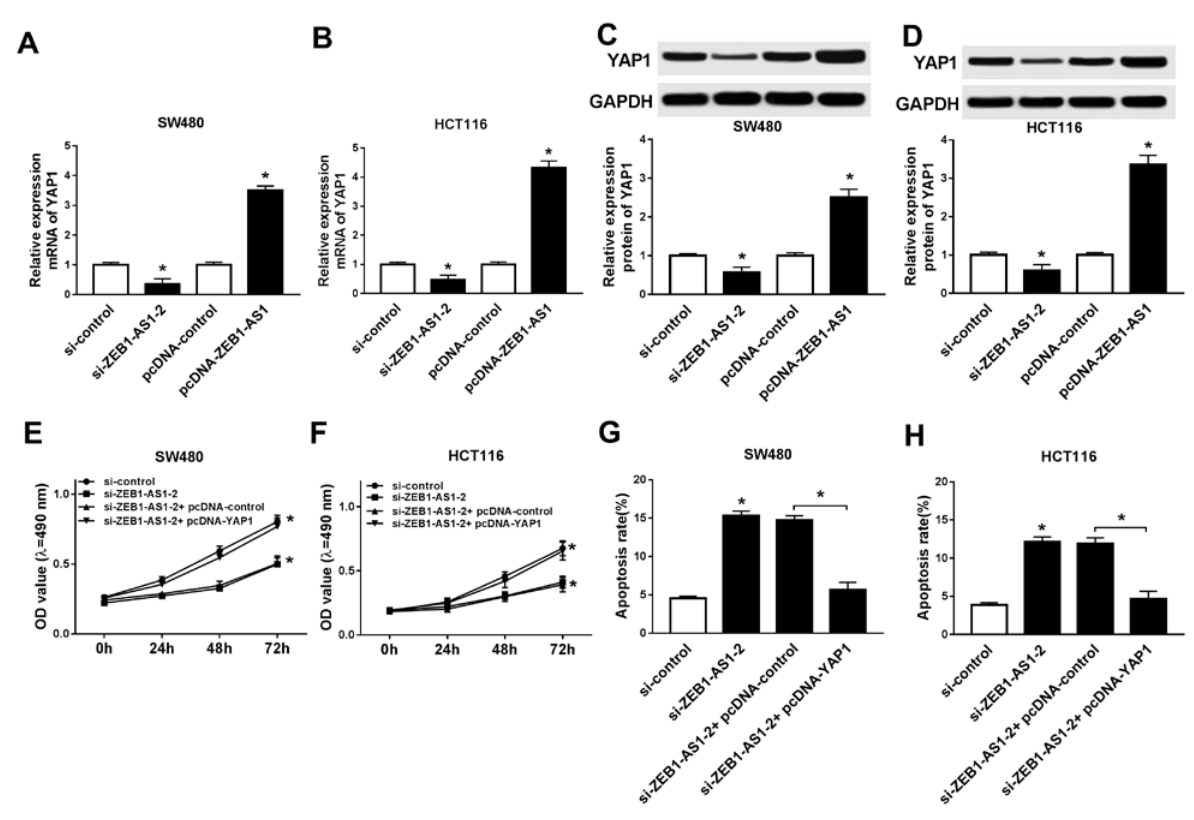
Figure 3: YAP1 overexpression reversed effects of ZEB1-AS1 knockdown on proliferation and apoptosis of CRC cells (A) The mRNA expression of YAP1 in SW480 cell after ZEB1-AS1 knockdown and overexpression. (B) The mRNA expression of YAP1 in HCT116 cell after ZEB1-AS1 knockdown and overexpression. (C) The protein level of YAP1 in SW480 cell after ZEB1-AS1 knockdown and overex- pression. (D) The protein level of YAP1 in HCT116 cell after ZEB1-AS1 knockdown and overexpression. (E) Cell proliferation of SW480 after ZEB1-AS1 knockdown and YAP1 overexpression. (F) The proliferation of HCT116 after ZEB1-AS1 knockdown and YAP1 overexpression. (G) Cell apoptosis of SW480 after ZEB1-AS1 knockdown and YAP1 overexpression. (H) Cell apoptosis of HCT116 after ZEB1-AS1 knockdown and YAP1 overexpression.* means p <